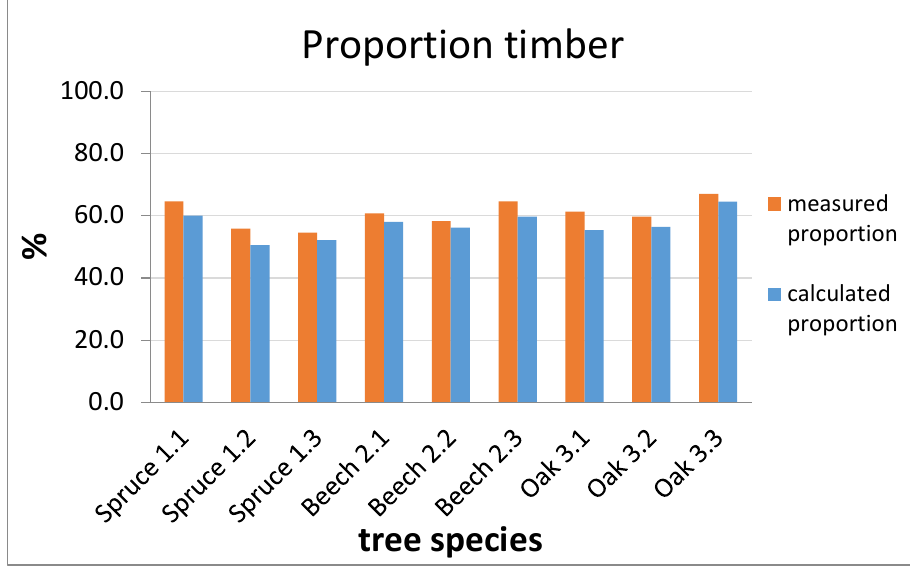
Figure 13. Graphical comparison of the measured and calculated proportion of timber produced from the cutting pattern implementation.